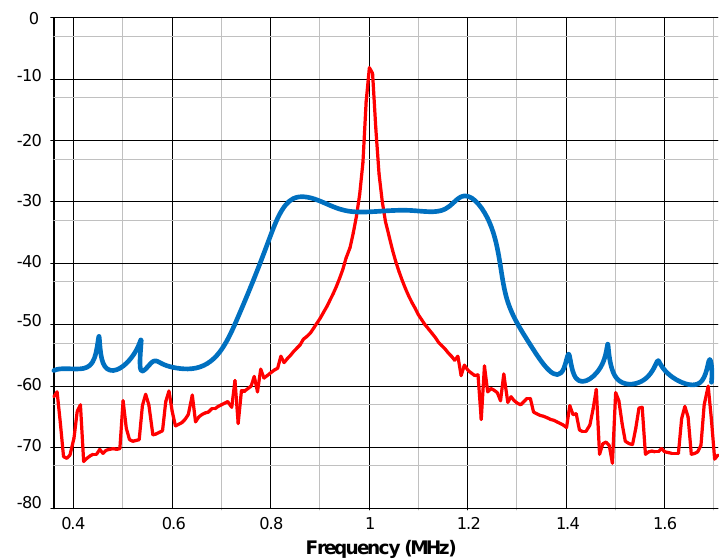
Figure 4. Spectrum waveform with and without spread-spectrum technique.